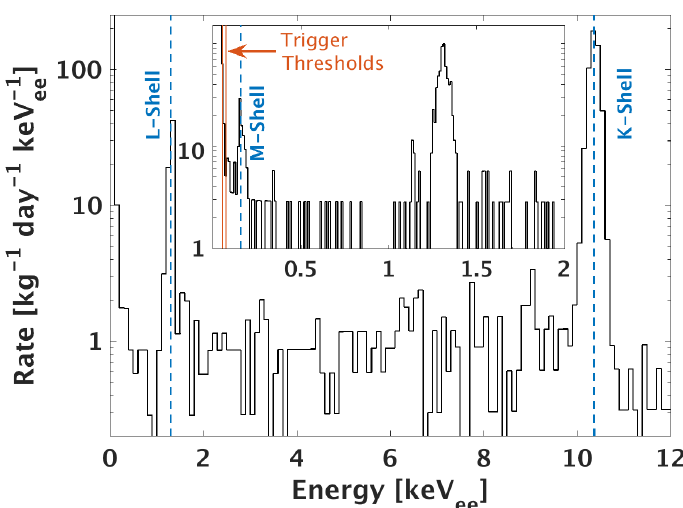
Figure 36: Illustration of the resolution of a SuperCDMS HV detector using the WIMP- search spectrum after application of all cuts and correcting for efficiency (except trigger efficiency) in the CDMSlite detectors. Inset shows a zoom (with smaller bin size) of the energy range actually used to the set the limit. 71 Ge activation peaks are marked with blue dashed lines. Adapted from [ 44 ]